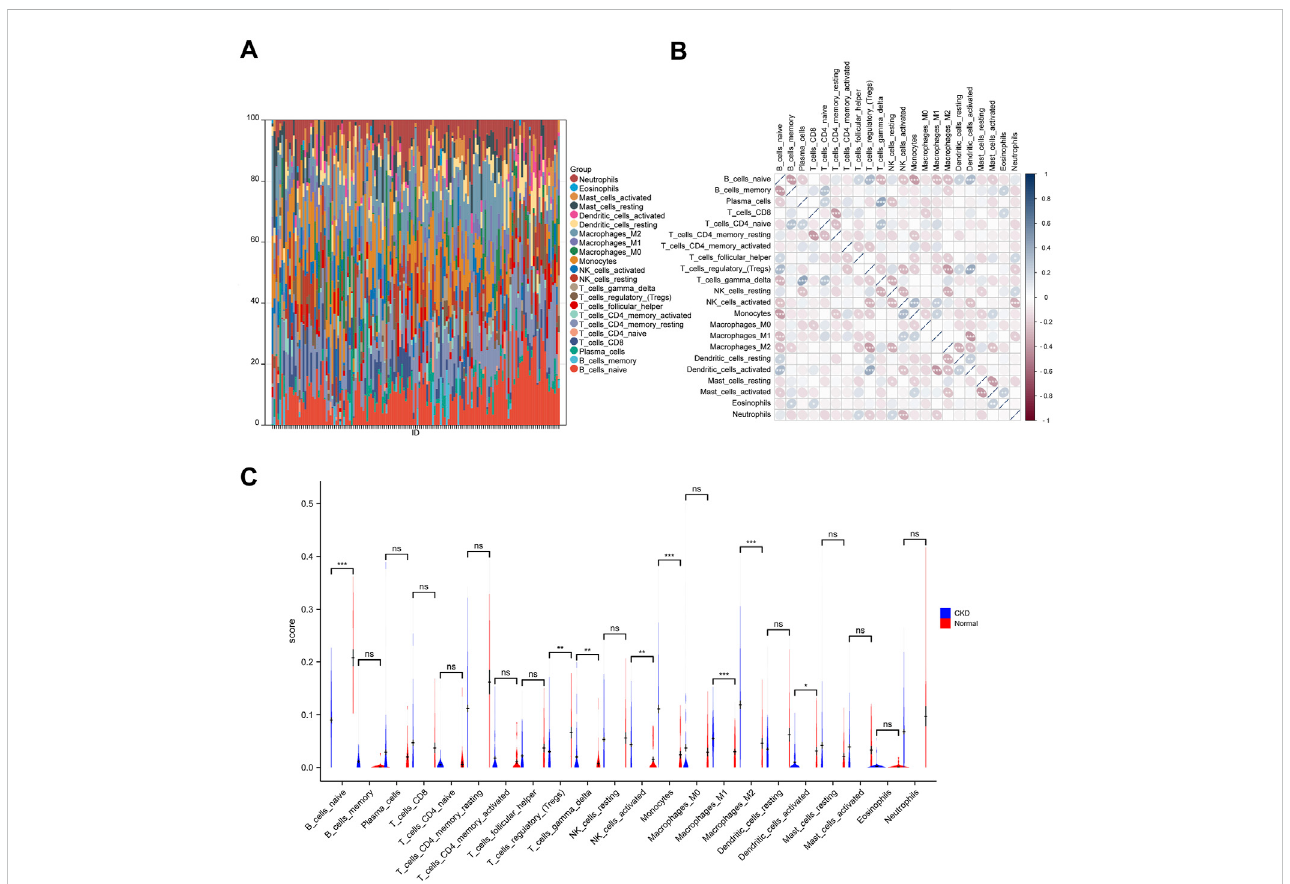
FIGURE 8 Immune in fi ltration analysis of CKD. (A) The ratio of 22 immune cells of each sample of CKD. (B) The correlation between each of immune cells. (C) The proportion of immune cells in CKD and control.